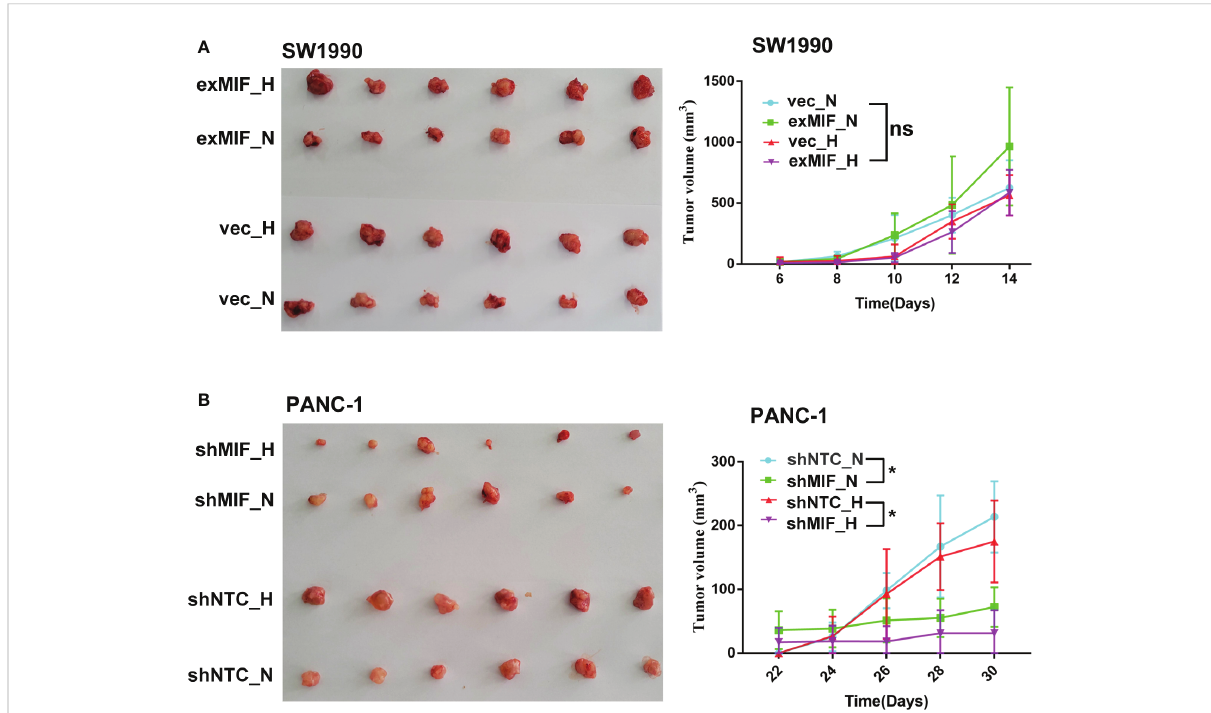
FIGURE 6 MIF knockdown attenuates the tumorigenesis of PDAC cells in vivo Representative images and quanti fi cation of subcutaneous xenograft tumours (n = 6 in each group) from stably transduced cell lines SW1990 (A) and PANC-1 (B) in nude mice after sham operation (N, normoxia) or femoral artery ligation (H, hypoxia). ns, no signi fi cance; * P <